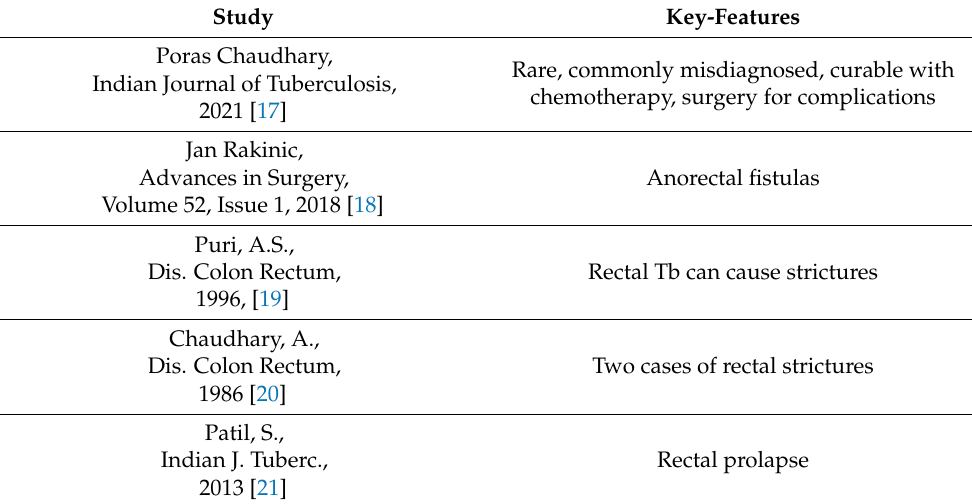
Table 4. Rectal tuberculosis: literature studies and their key